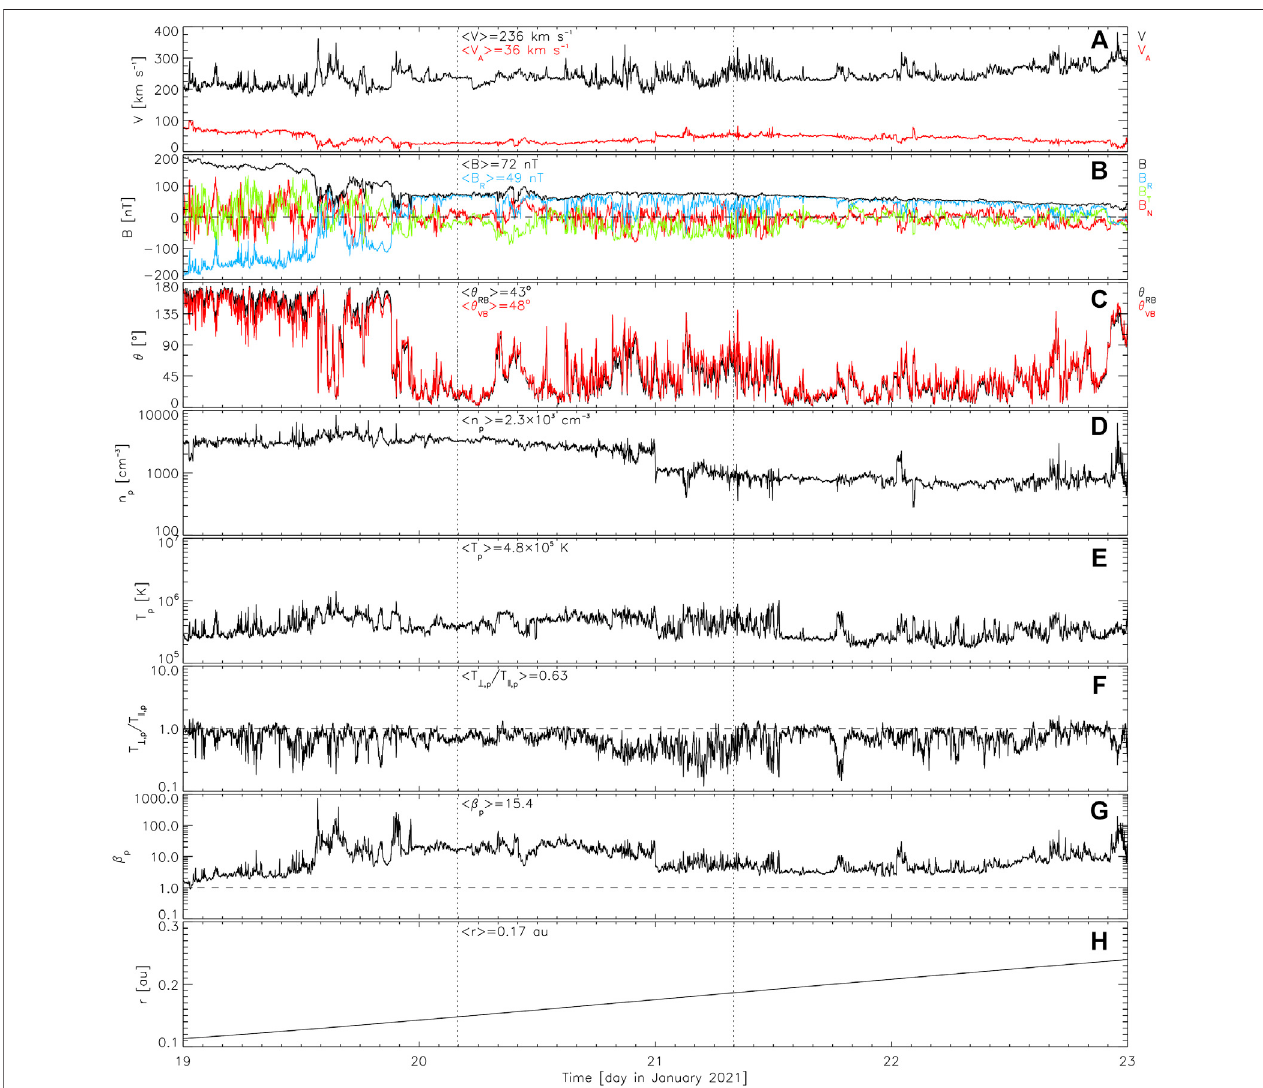
FIGURE 2 | Overview of the PSP — Sun quasi co-rotation interval (between vertical dotted lines) identi fi ed during encounter 7, showing (A) the solar wind V and Alfvén V A speed, (B) themagnetic fi eldvectorcomponents( B R , B T , B N )andintensity B , (C) theangles θ RB and θ VB ofthemagnetic fi eldvectorwiththeradialdirectionand theplasma fl owvelocityvector, (D) theprotondensity n p , (E) temperature T p , (F) temperatureanisotropy T ⊥ , p / T (cid:4) , p ,and (G) plasmabeta β p ,and (H) thedistance r ofPSP from the Sun. Average values during quasi co-rotation are reported within each